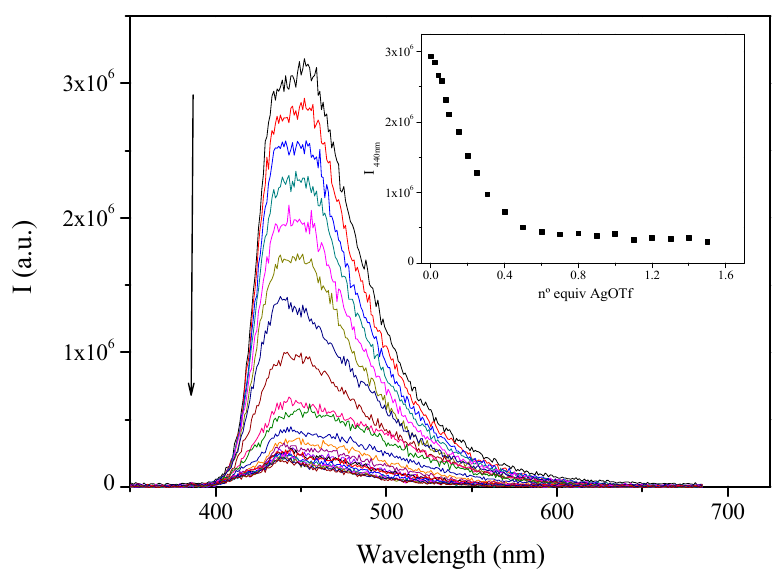
Figure 5. Emission spectra of a 1 × 10 − 5 M dichloromethane solution of 4 upon addition of increasing amounts of AgOTf. Inset: variation of emission maxima at 440 nm at each titration point.